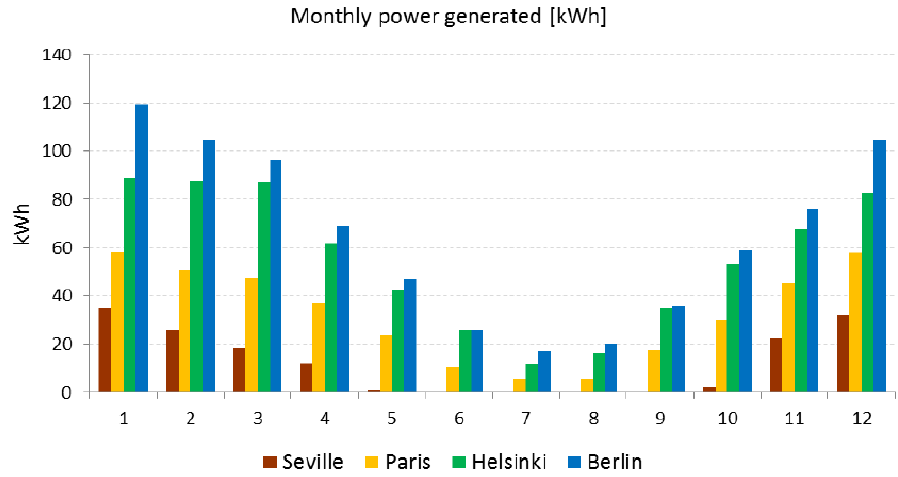
Figure 10. Comparison of monthly generated power (in kWh) in Seville, Paris, Helsinki and Berlin.